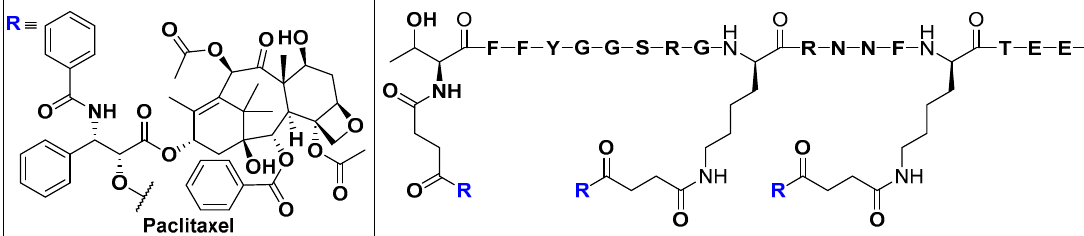
Figure 17. Structure of the paclitaxel-Angiopep-2 conjugate (ANG1005) engineered to deliver paclitaxel to the brain by exploiting low-density lipoprotein receptor-related protein (LRP)-mediated transcytosis. Angiopep-2 was discovered by sequence alignment of LRP substrate proteins, such as amyloid precursor protein (APP) and aprotinin. Paclitaxel is released upon hydrolysis of ester linkages by hydrolyzing enzymes.